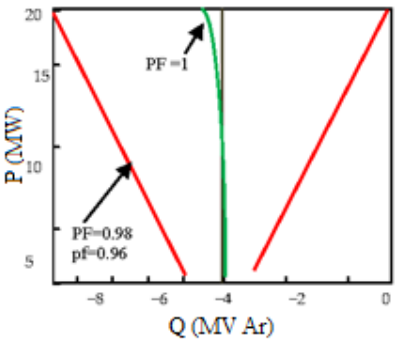
Figure 3. Q characteristic for WF in G80-2.0MWWTs.